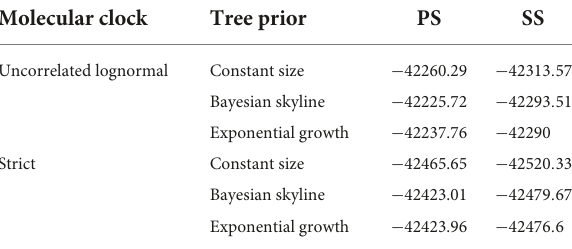
TABLE 4 The comparison among different models